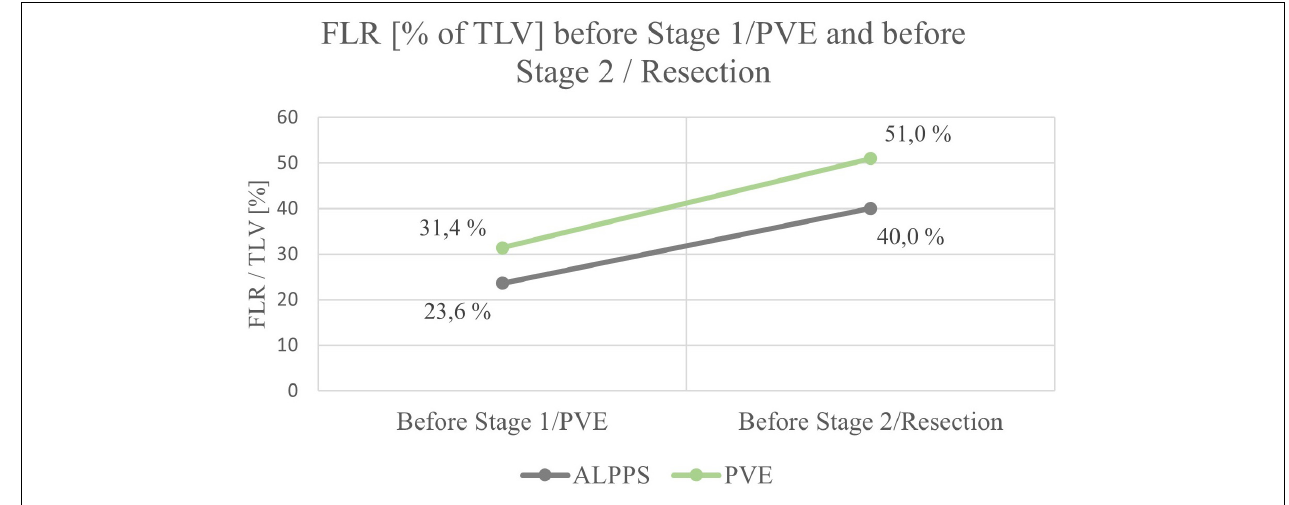
FIGURE 4 | Mean FLR before and after the first stage of the